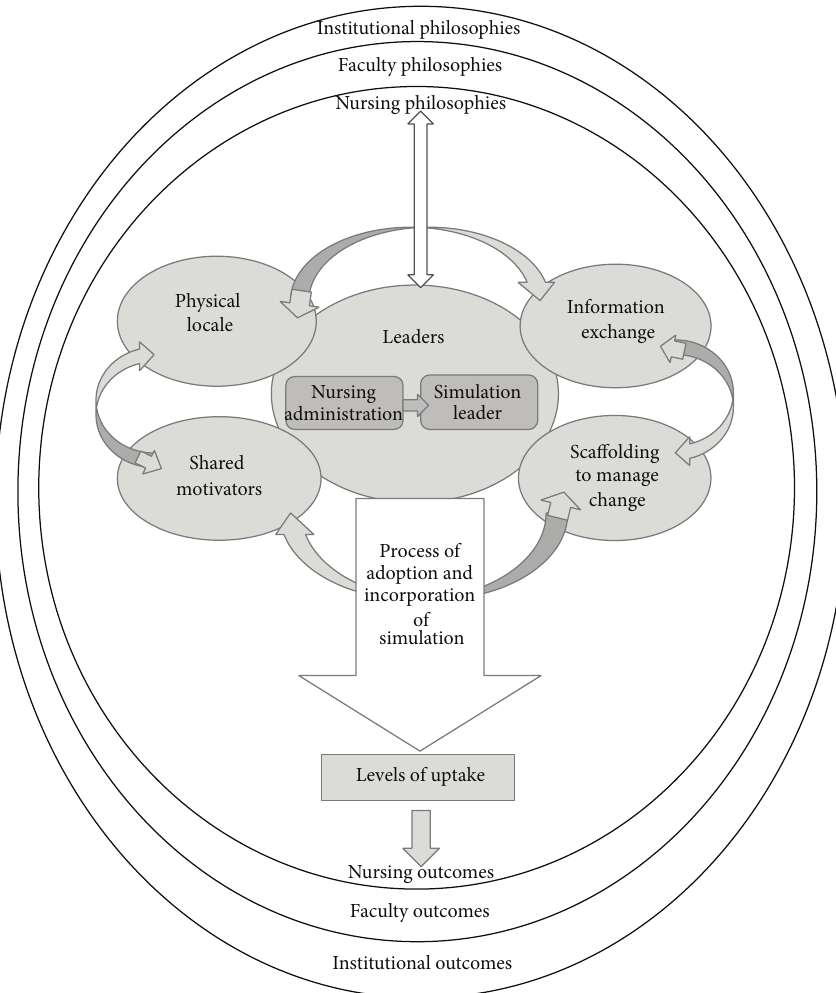
Figure 1: The organizational elements that shape simulation in